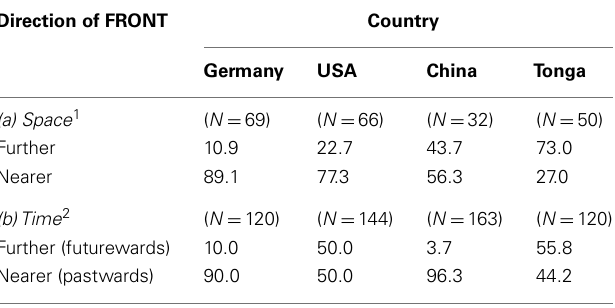
Table 3 | Percentage of individuals assigning FRONT either further away from or nearer to the observer in (a) the spatial and (b) the temporal tasks.